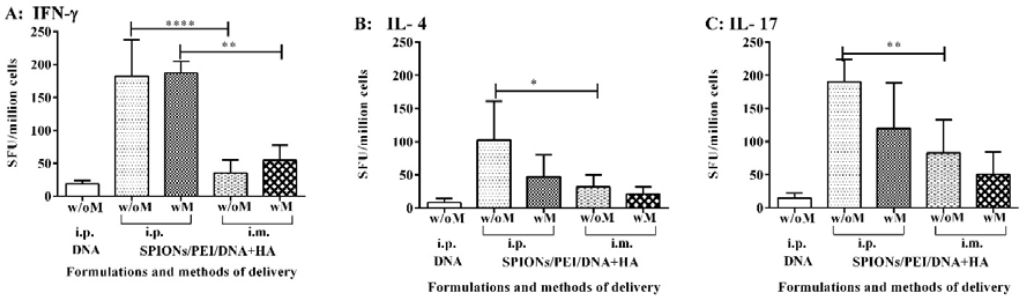
Figure 4. Antigen ‐ specific T cell responses induced by the SPIONs/PEI/DNA + HA complexes in vivo . BALB/c mice ( n = 5/group) were immunised 3 times (3 weeks apart) with SPIONs/PEI/DNA + HA or naked DNA, via i.p. and i.m. administration, with or without the application of an external magnetic field. Two weeks after the final immunisation (day 56), mice were humanely sacrificed, and splenocytes were harvested and assayed for antigen ‐ specific T cell responses, measured by the induction of IFN ‐γ , IL ‐ 4, and IL ‐ 17 cytokine production, upon stimulation with the recall antigen (recombinant EcPyMSP1 19 ) in ELISpot assays. All data expressed as mean of spot ‐ forming units (SFU)/million cells ± SD. ( A ) IFN ‐γ ; ( B ) IL ‐ 4; ( C ) IL ‐ 17 responses. Statistical significance was designated as * p ≤ 0.05, ** p < 0.01, **** p < 0.0001.